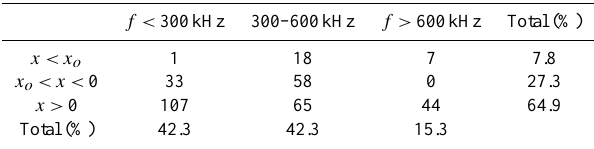
Table 2. Sorting of DF results for Fig. 4. Table 3. Sorting of DF results for Fig.